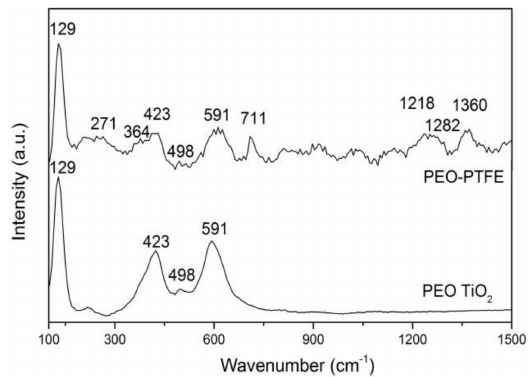
Figure 4. Raman spectra of the PEO TiO 2 coating and PEO–PTFE composite coating.